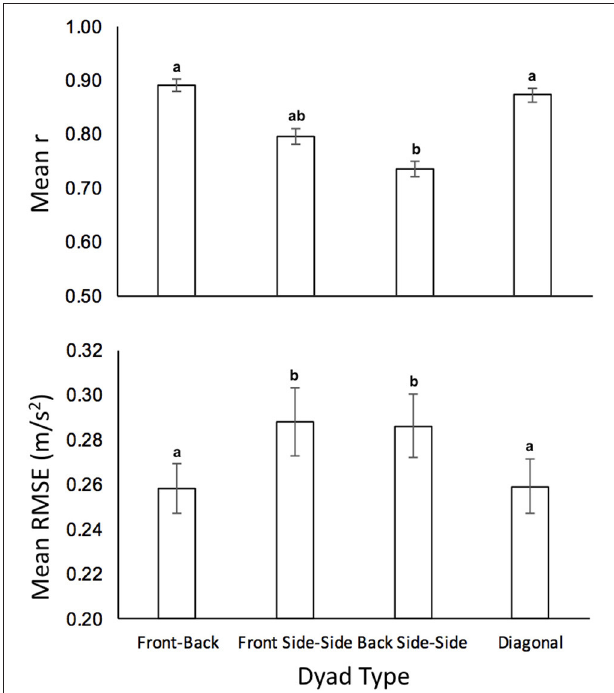
FIGURE 10 | Bar graphs of simulation results for mean correlations between real dyads (Top) , and RMSE between real dyads (Bottom) . Duncan grouping specifies significant